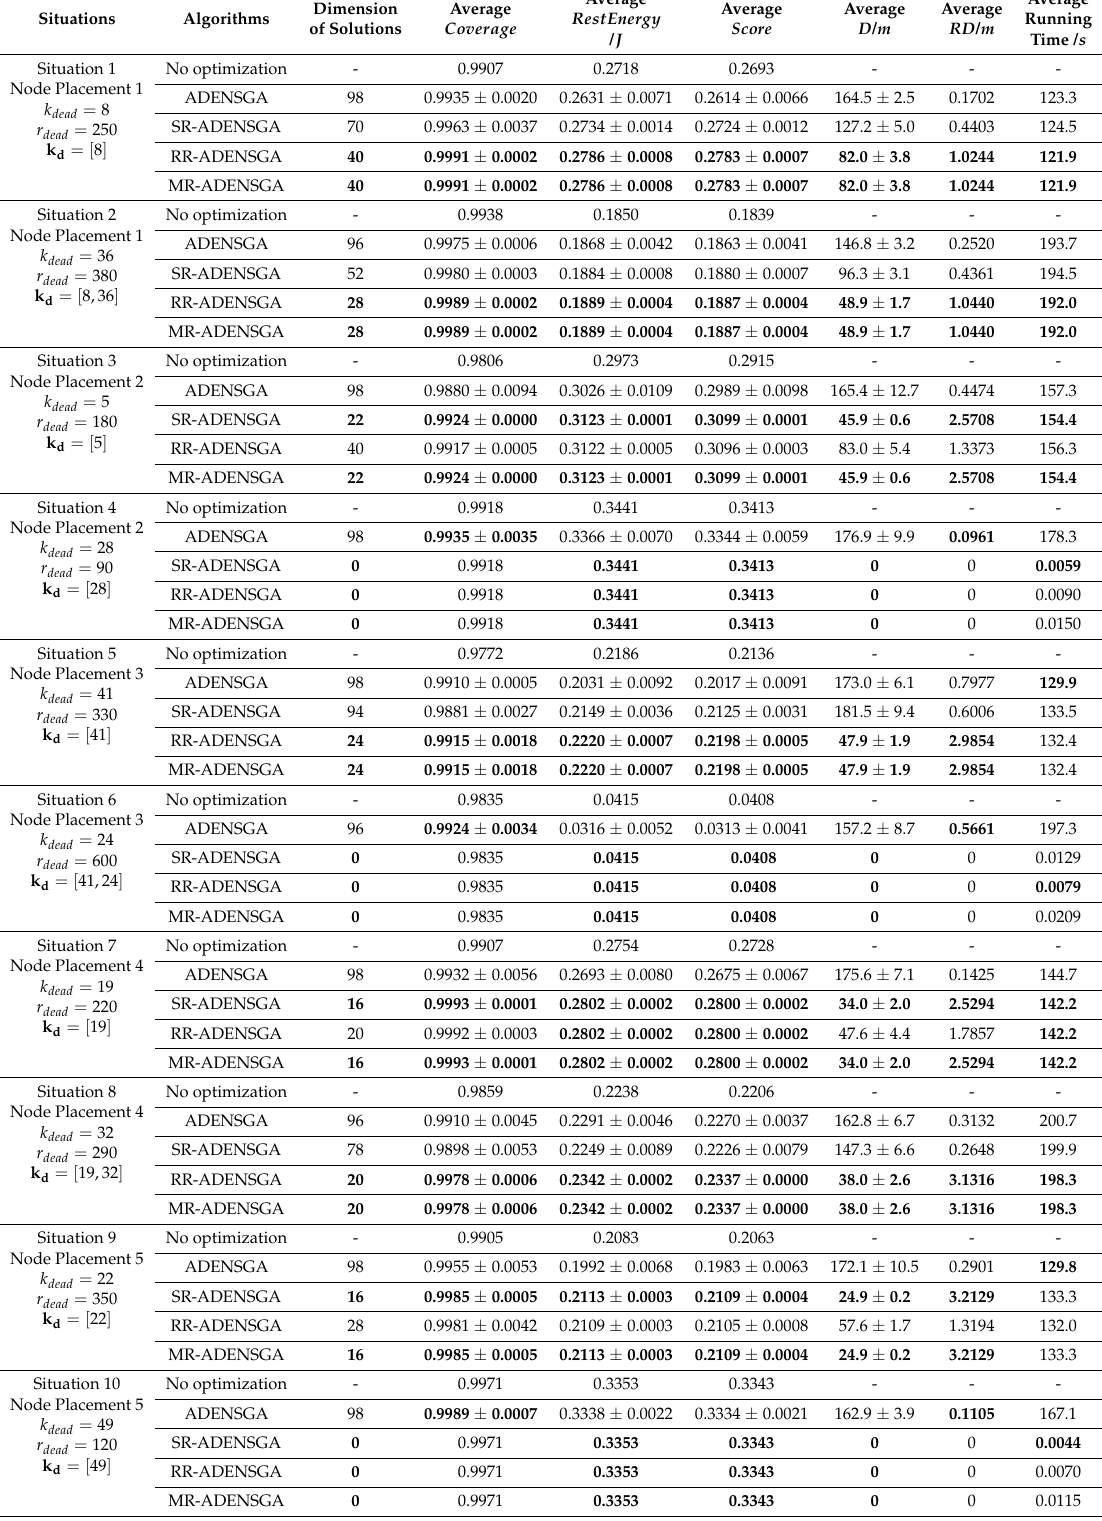
Table 2. Optimization Results for Different k dead and r dead